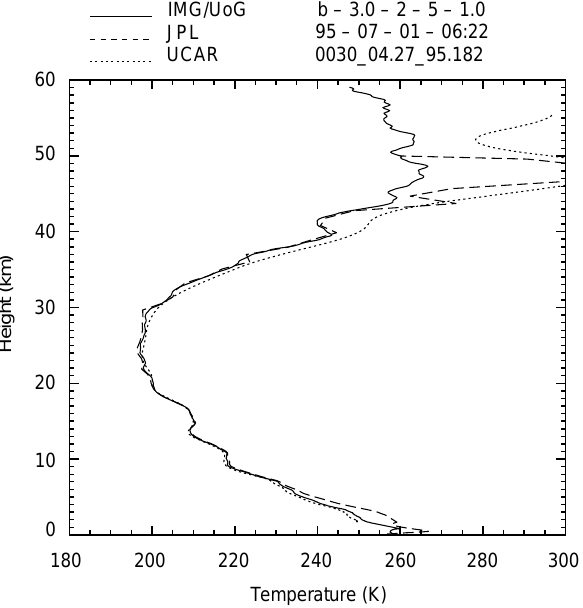
Fig. 6. Comparison of GPS/MET temperature profiles retrieved by IMG ( solid line , retrieval from UCAR level2 data), by scientists of the Jet Propulsion Laboratory (JPL, dashed line , ecmwf-format data file) and by the Universities Corporation for Atmospheric Research (UCAR, dotted line , GPS/MET database). The occultation event (0030-04.27-95.182)wasplacedat62 (cid:14) S,144 (cid:14) Won1July1995,6:22UT